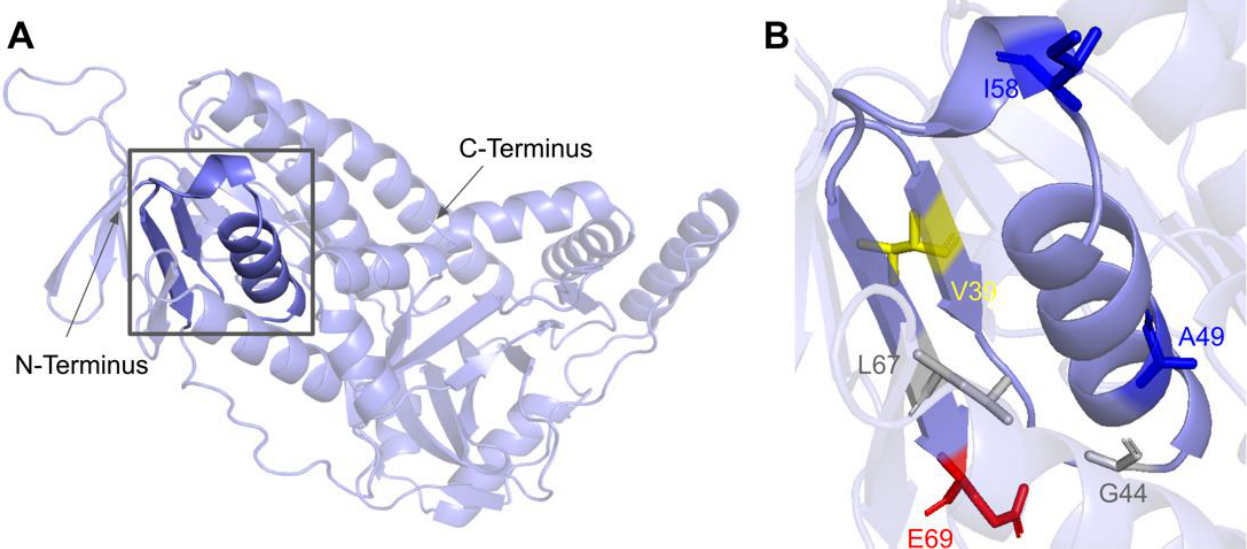
Figure 21. SNVs in the COQ6 ADP-binding fingerprint. ( A ) The ADP-binding βαβ -fold is high- lighted on the COQ6 model and includes residues D37 to E69. Residues 1 – 35 have been truncated. ( B ) Locations of SNVs are depicted. Residues are colored according to their corresponding SNVs in Figure 19.